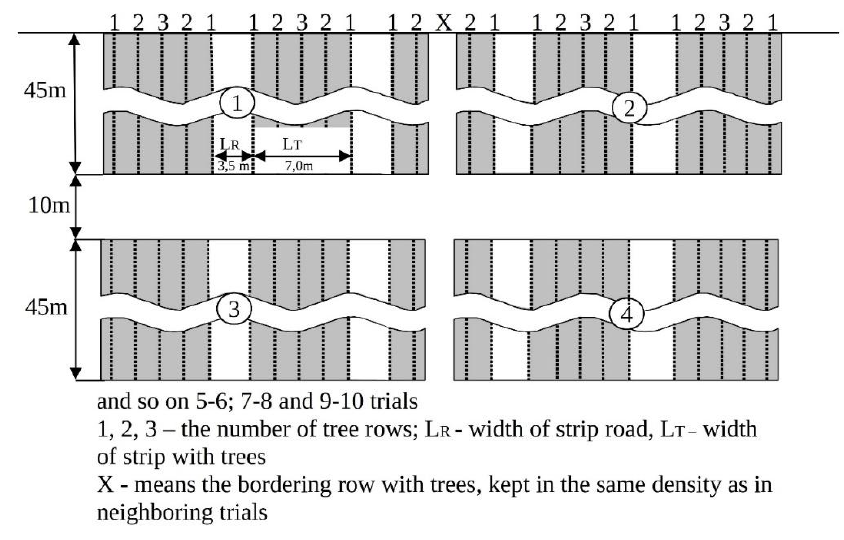
Figure 2. The scheme of experimental area design.